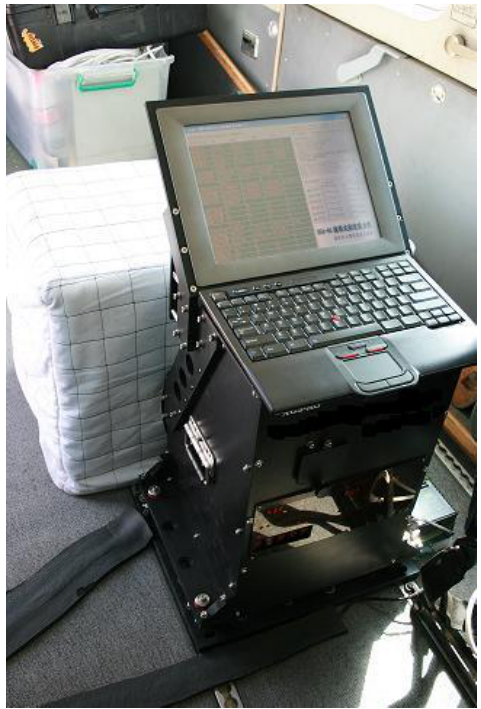
Figure 1. Appearance of the SGA-WZ.